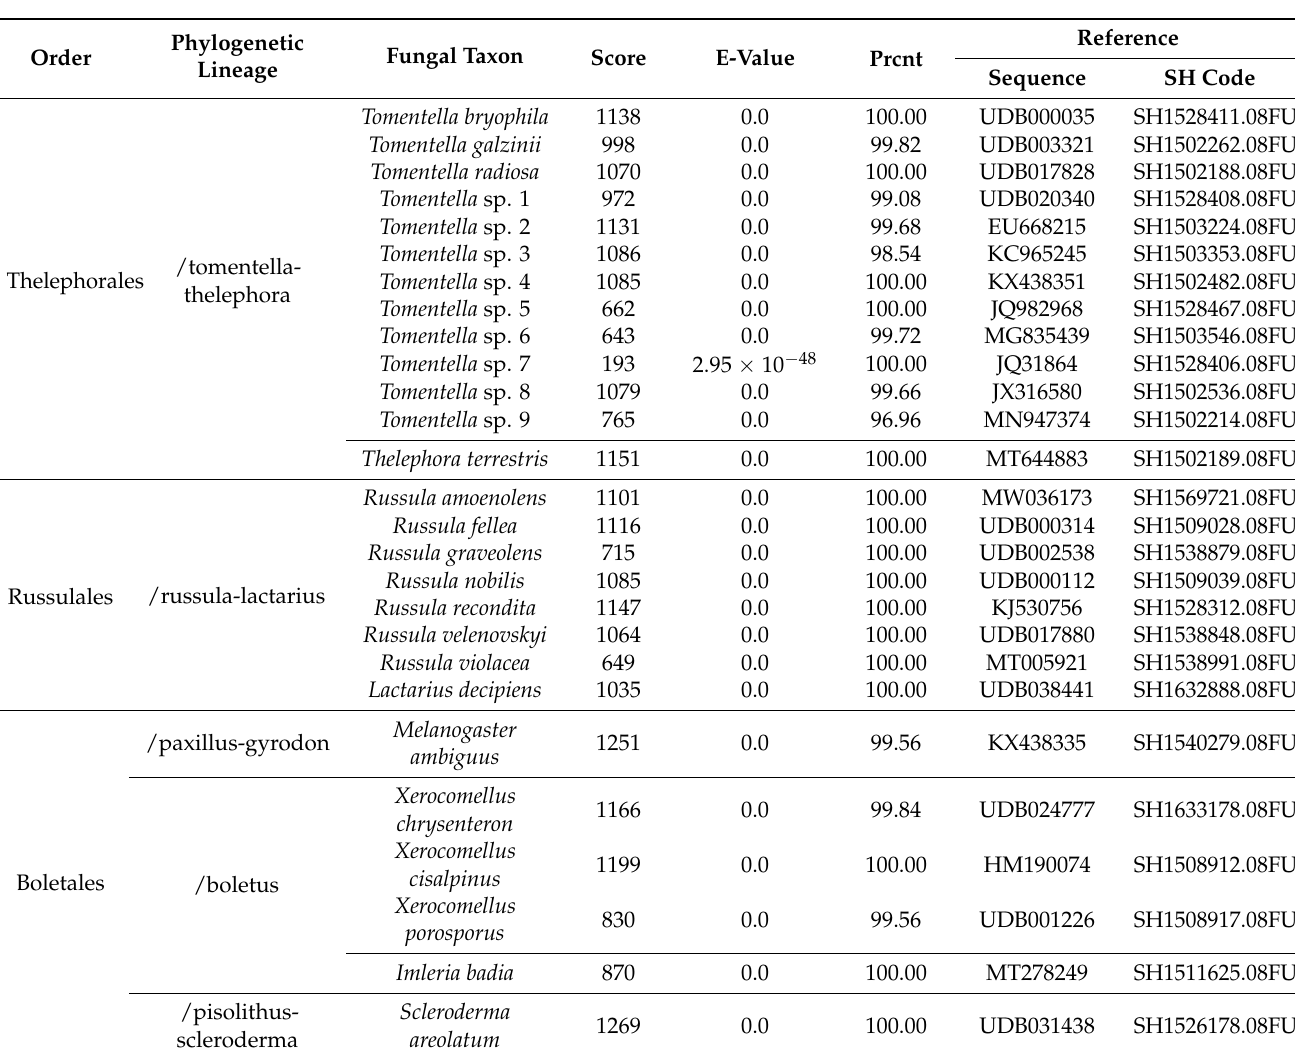
Table 3. The phylogenetic lineages of ectomycorrhizal fungi represented by identified ECM fun- gal